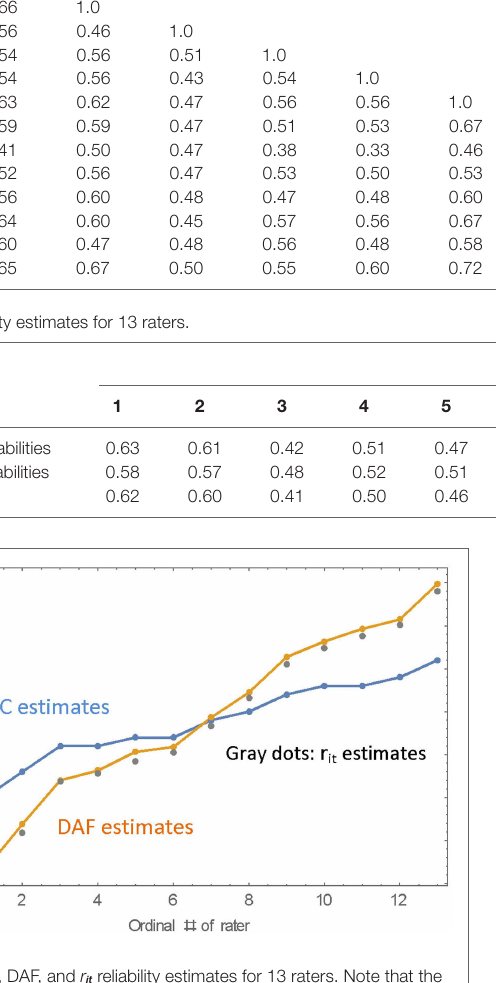
FigUre 5 | MIC, DAF, and r it reliability estimates for 13 raters. Note that the rater number is the ordinal number of the rater when sorting the raters by the magnitude of the reliability estimate.